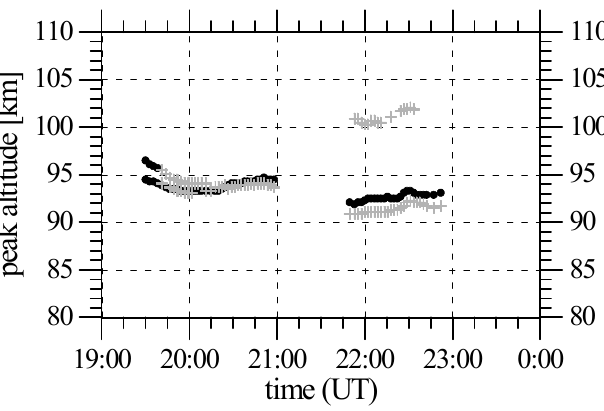
Fig. 1. Series of density profiles ob- tained in the evening of April 7, 1997 for Ca + (upper panel) and Ca (lower panel). The Ca + profiles show a strong layer around 94 km and weak layers above 100 km altitude. The Ca profiles show a strong sporadic layer around 94 km only. Note the different density scales in the two panels.